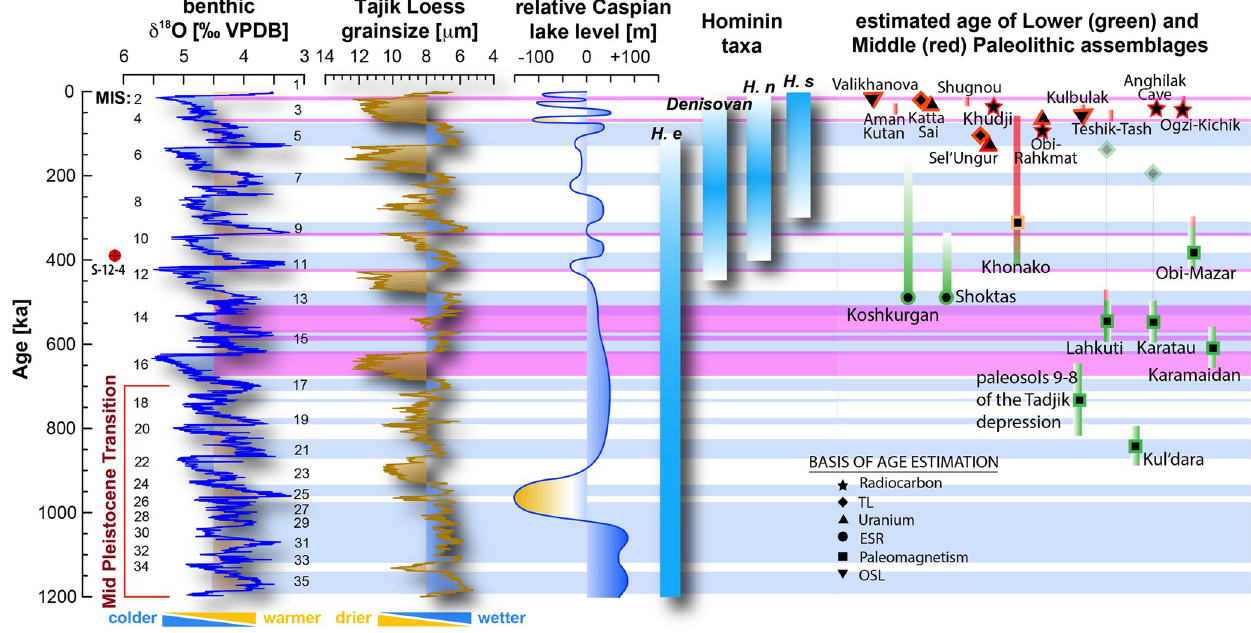
Fig 2. Climate variables and evidence of hominin occupation in Central Asia through time. Global oxygen isotope records with numbered MIS interglacials (CENOGRID dataset) [29], the Tajik loess record [26], and relative Caspian Sea level variation [19]. Blue shading indicates wet intervals in the Tajik loess record and pink shading indicates intervals of Caspian outflow into the Black Sea [19]. All known hominin taxa from Central Asia during the Pleistocene ( Homo erectus [H.e.], Denisovans, Homo neanderthalensis [H.n.], Homo sapiens [H.s.]) are displayed alongside the suggested chronology for Lower (green) and Middle (red) Paleolithic assemblages. Symbols indicate the basis of age estimations and assemblages without symbol represent dates previously proposed in the literature but are unverified/not tested by dating methods.